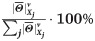
Regulation of key reactions by their substrates and products.(A-F) Relative average absolute contribution, i.e. |Θ¯|Xjv∑j|Θ¯|Xjv∙100%, of metabolites to the transition from the steady state at 0.1 μM to the indicated concentration of palmitoyl-CoA, calculated for vMCKATC6 (panel A), vMCKATC4 (panel B), vMCADC6 (panel C), vSCADC4 (panel D), vMPTC8 (panel E), vCPT2C16 (panel F).